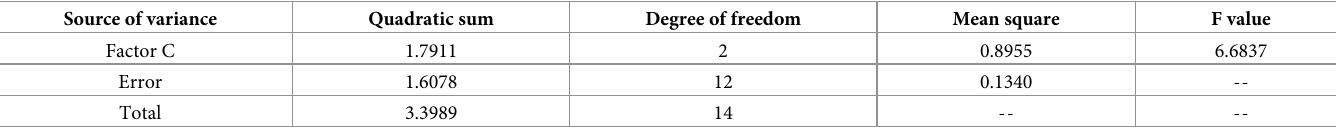
Table 3. Variance Analysis of separation force at different tension angles. Source of